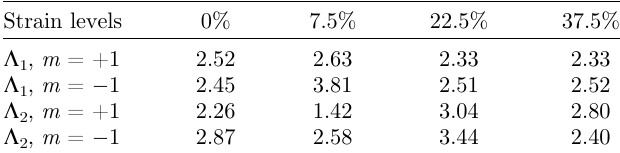
Figure 8. The determined horizontal periodicity, according to equation (2), of (left column) K 1 and (right column) K 2 based on the (top row) +1 order diffraction and (bottom row) (cid:2) 1 order of diffraction. Table 2. Estimated horizontal periodicities ( K 1 and K 2 ) in the horizontal plane of the bi-material sample for different strain